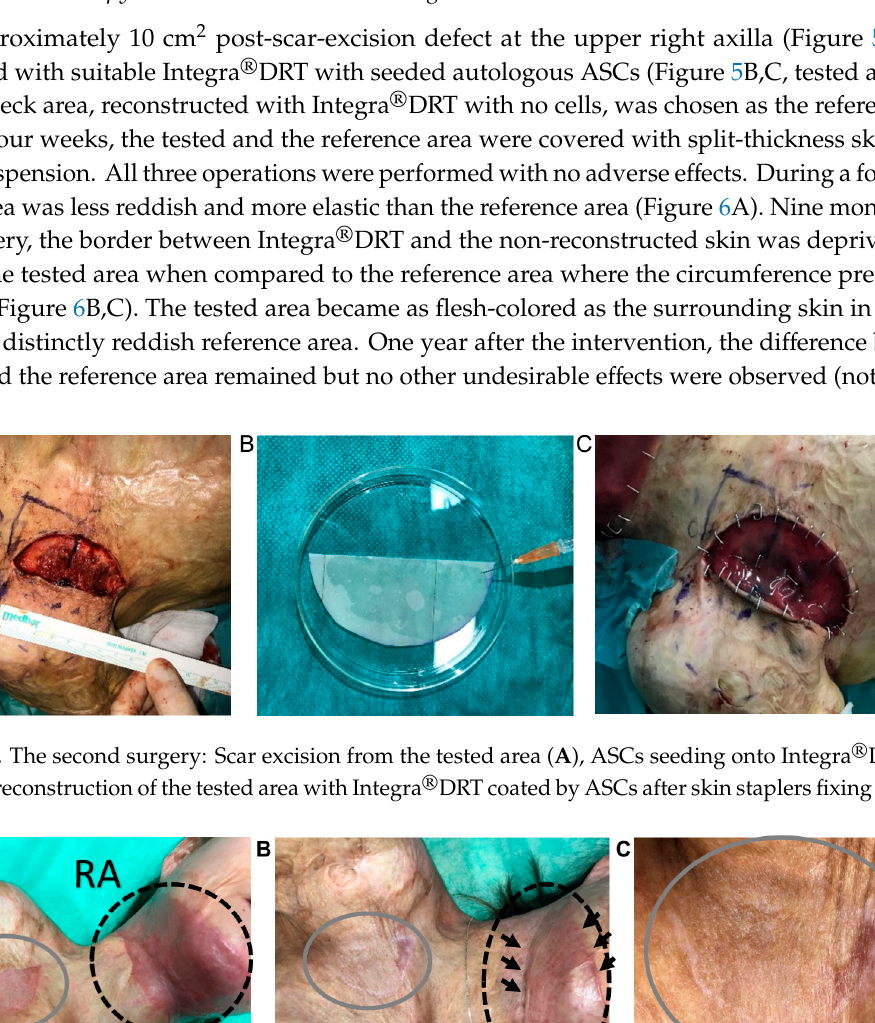
Figure 4. The elasticity of ASC–Integra ® DRT constructs on days 2, 7, and 14 after cell seeding expressed as storage modulus ( A ). Collagenolytic activity of the constructs ( B ). The decrease in ASC– Integra ® DRT elasticity was positively correlated with the increase in the proteolytic activity at the same time points.